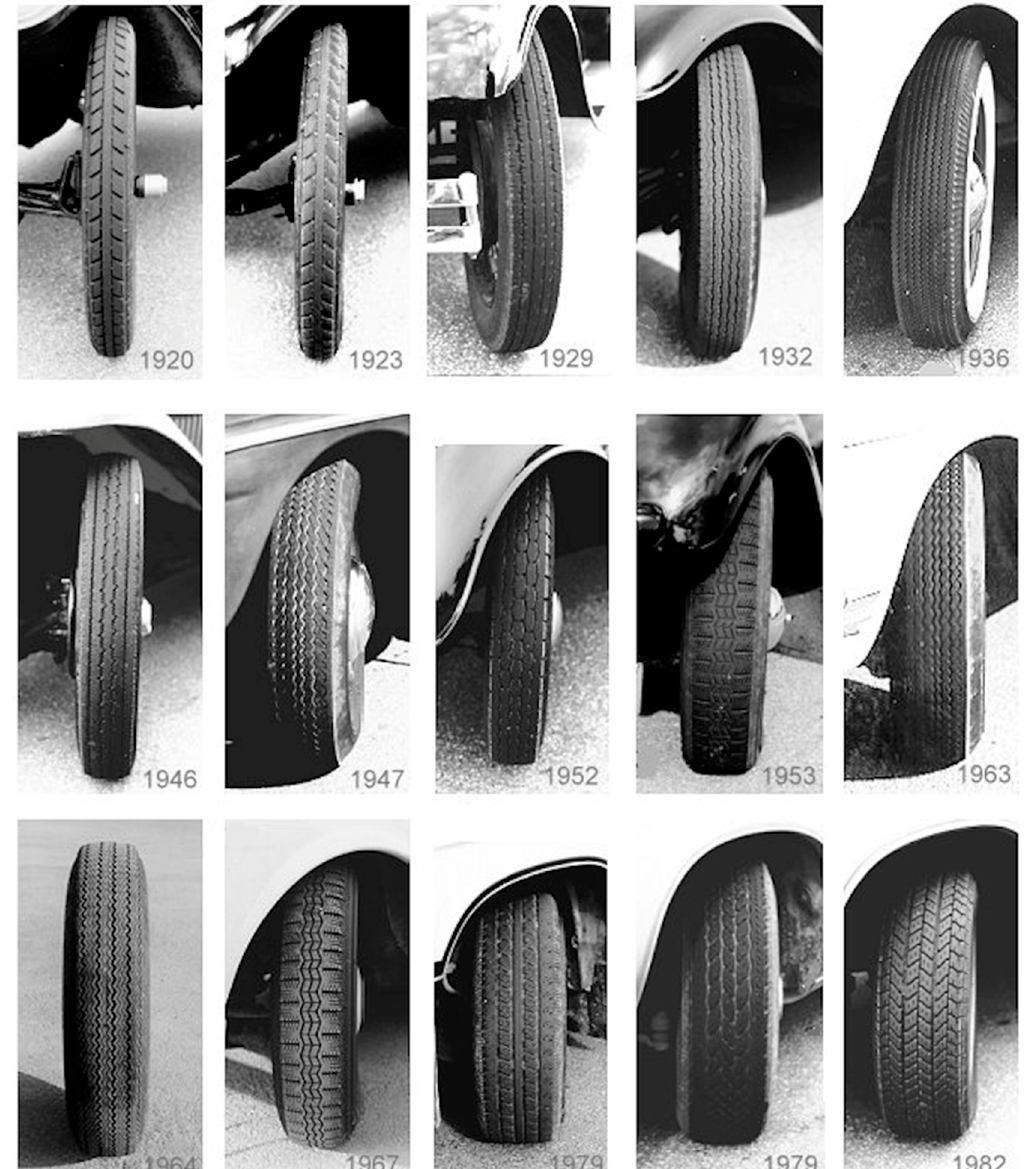
Figure 7. Common tires with year indicated (source from Sandberg and Ejsmont, 2002 [1], Figure 6.5; reprinted with permission from Dr. Ulf Sandberg of VTI, Sweden).